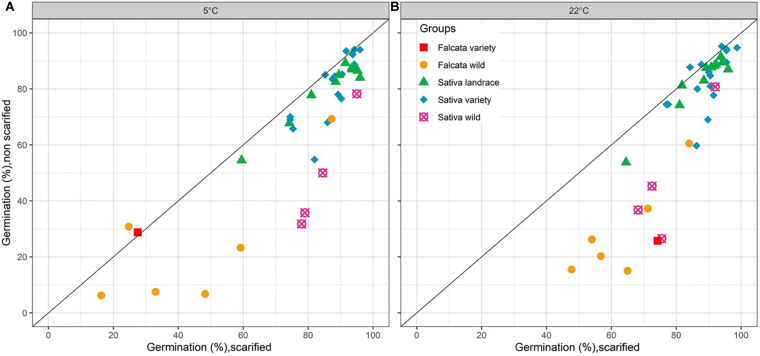
Germinability (observed data, average of 4 biological repetitions) of 38 lucerne populations from 5 different groups with or without scarification at 5°C (A) and 22°C (B).